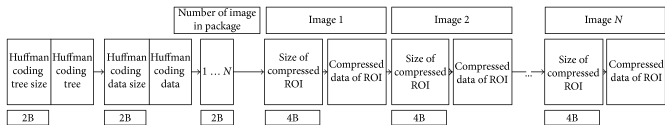
Dynamic file structure.